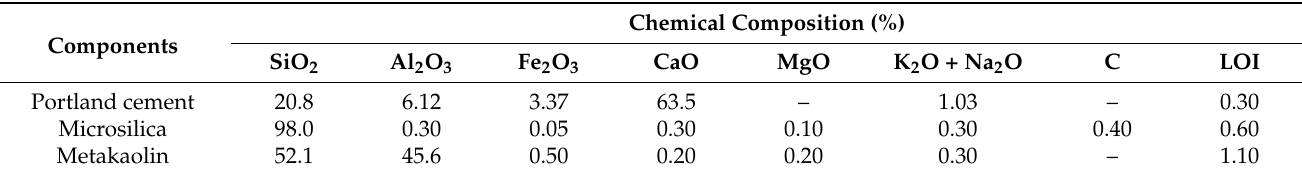
Table 1. Chemical composition of PC, microsilica, and metakaolin.